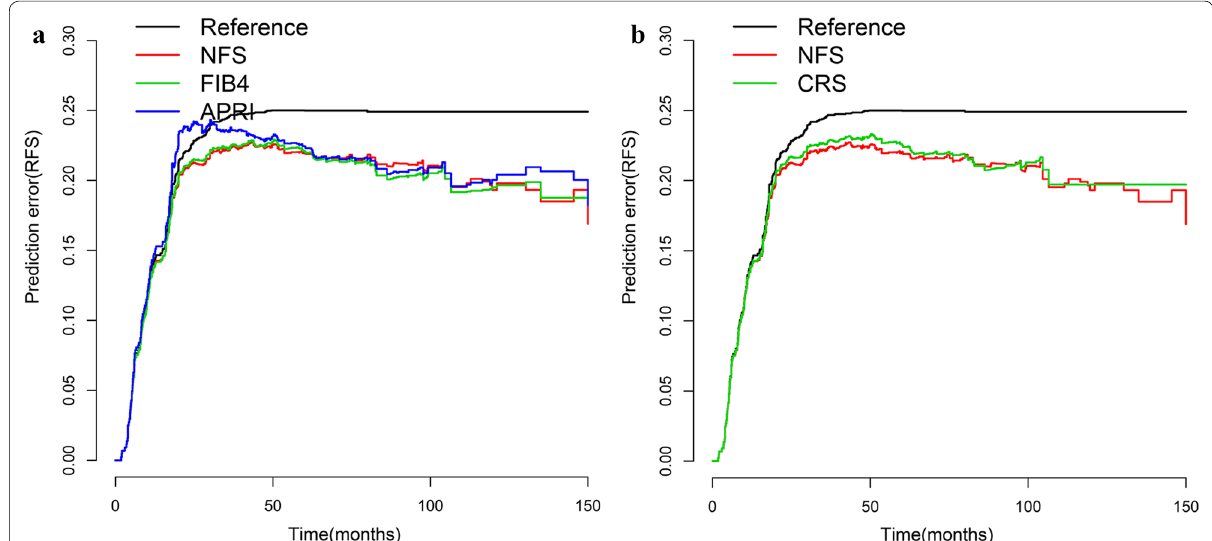
Fig. 7 Prediction error curves for each model for stratifying liver RFS in the validation cohort. a Prediction error curves for the NFS, FIB4 and APRI score. b Prediction error curves for liver fibrosis and CRS score. Lower prediction errors indicate higher model